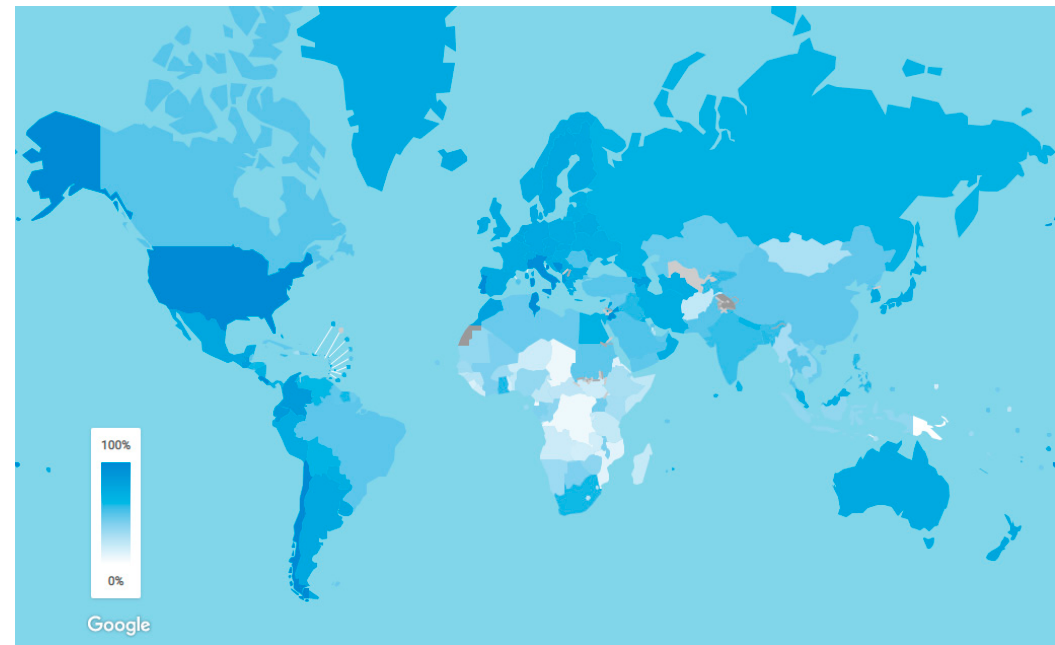
Figure 1. Proportion of the population using improved drinking water sources in 2015. Source: The World Health Organization (WHO) and UNICEF, 2015